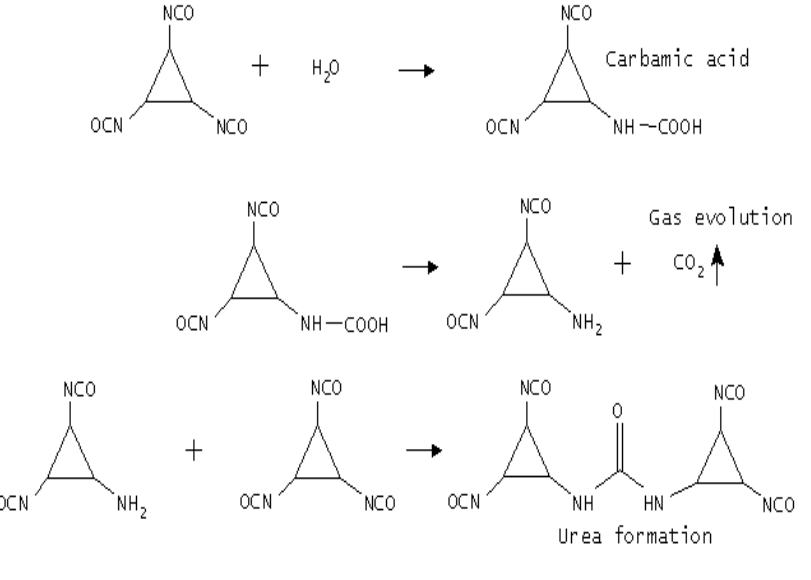
Figure 1. Isocyanate reactions with H